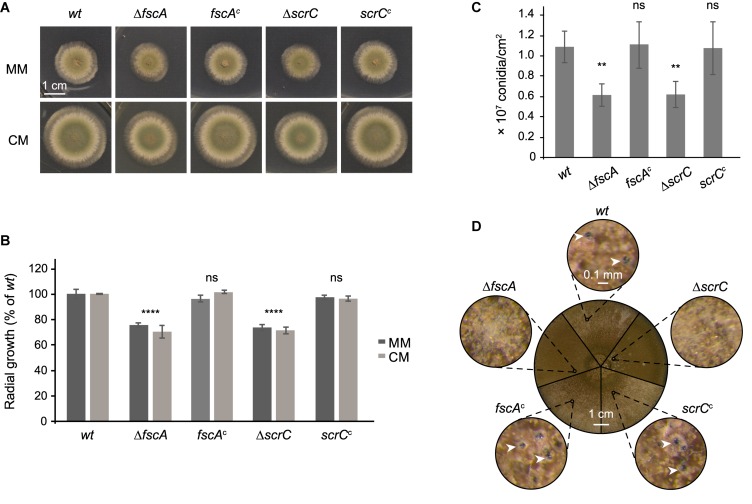
ΔscrC and ΔfscA strains display reduced radial growth and conidiation and are lacking sexual reproduction. Wild type, deletion, and complemented strains were dotted (1 × 104 conidia each) onto MM and CM plates supplemented with arginine and biotin and incubated at 37°C. Unless otherwise indicated, MM was used as growth medium. (A) Morphology of representative colonies incubated for 48 h is shown. (B) Colony areas of strains grown on MM or CM for 48 h were quantified using Fiji (Schindelin et al., 2012). (C) Conidiation rates of wild type and mutant strains after growth for 7 days. Mean values in percent of wild type ± standard deviation of three biological replicates are displayed and statistical difference to the wild type was calculated by one-way ANOVA. *P < 0.05, **P < 0.01, ***P < 0.001, ****P < 0.0001, ns, not significant. (D) Sexual reproduction of wild type and mutant strains. Plates were sealed and incubated for 3 weeks in the dark. The circle in the center shows sectors of photographs of the plates of the different strains as indicated. Outer circles show details of the small circles in the center at 60×magnification. White arrow heads point to cleistothecia.